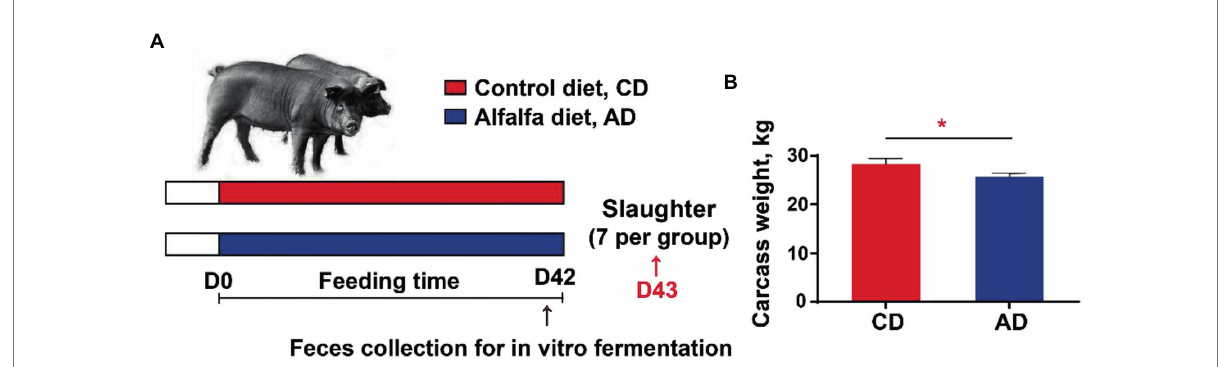
FIGURE 1 Experimental design (A) and carcass weight (B) . * p < 0.05. CD, control diet; AD, alfalfa